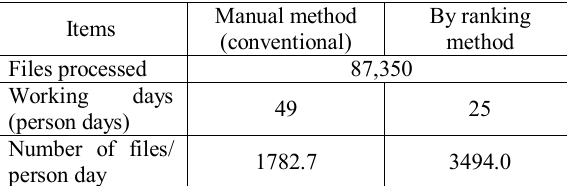
Table 6. Work efficiency and quality table by methods